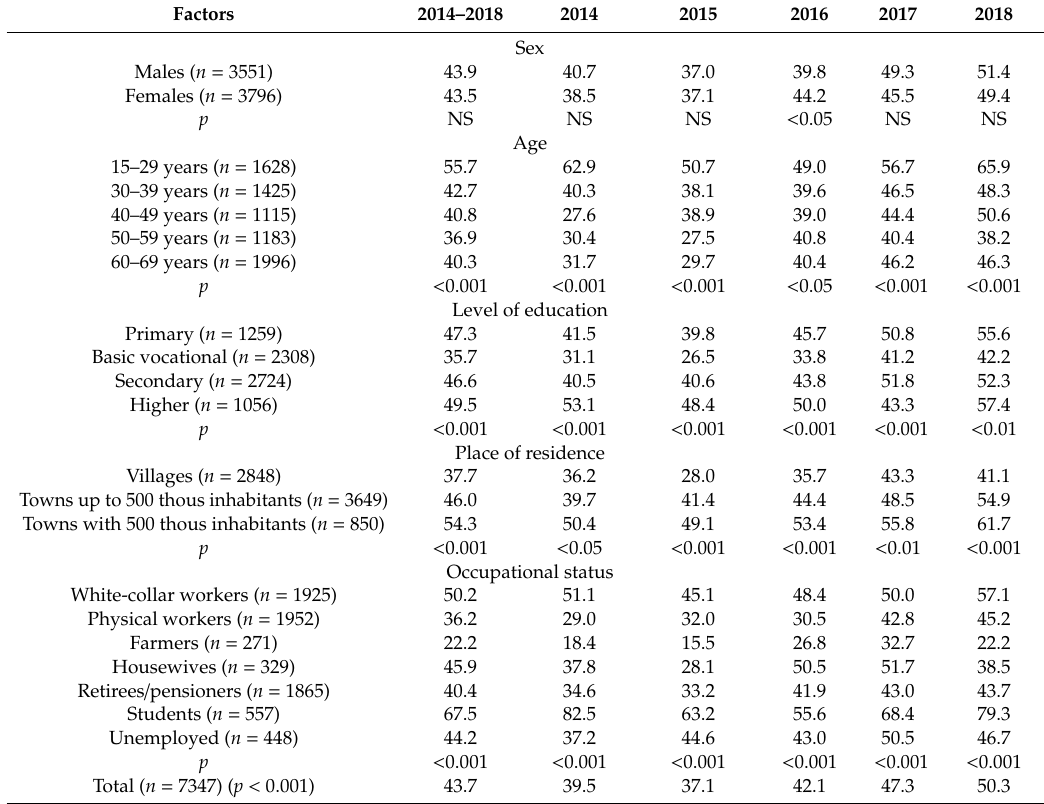
Table 3. Percentage of adult Poles meeting WHO PA recommendations in